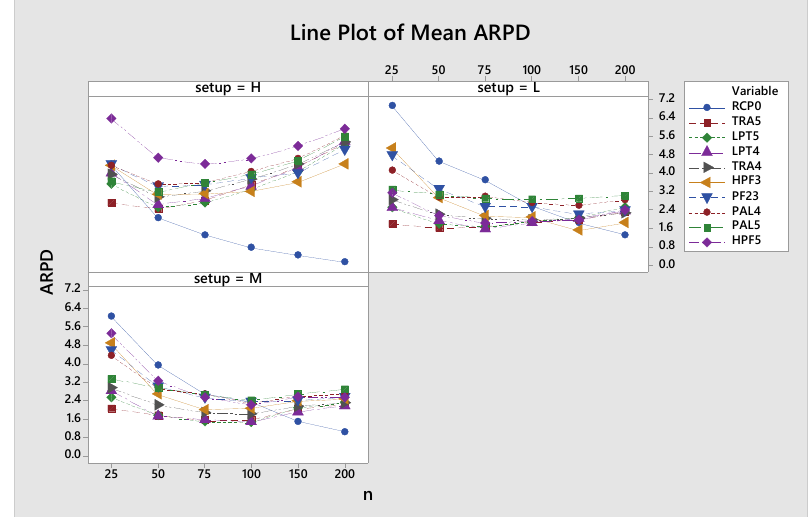
Fig. 3. ARPD per heuristic and number of jobs for each level of setup